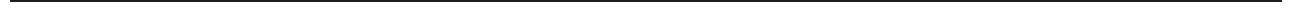
Fig. 3 FAPs drive spontaneous HO via endochondral ossi fi cation. a – c Spontaneous HO extended along the spine of a 22-week-old Acvr1 tnR206H/ + ; R26 NG/ + ; Tie2-Cre mouse. a µ CT detects calci fi ed heterotopic bone (bracket) but not the distal cartilaginous region of the lesion (asterisk). b Whole mount ABAR staining of the same mouse detects both lesional cartilage (blue; arrow) and bone (red; bracket). c Magni fi ed image of the boxed region in b . d – g Spontaneous HO (bracket) along the spine of a 6-week-old Acvr1 tnR206H/ + ; R26 NG/ + ;Pdgfr α -Cre mouse. The site of the most posterior chondrogenic area is shown at the asterisk in d and e . e ABAR staining shows the presence of two chondrogenic areas at the periphery of the predominantly boney lesion. f , g Higher magni fi cation images of areas denoted in e . Chondrogenic areas are shown at the arrow or bracket. h , i ABAR staining of the distal hindlimb of two 6-week-old Acvr1 tnR206H/ + ; R26 NG/ + ;Pdgfr α -Cre mice. Multiple chondrogenic areas (examples at arrows) are evident at the periphery of intramuscular boney lesions ( h ). In i , peripheral cartilage (arrow) is associated with HO of the Achilles tendon (arrowhead). B, heterotopic bone associated with the distal tibia/ fi bula. j – m Paraf fi n section of spontaneous HO from an adult Acvr1 tnR206H/ + ; R26 NG/ + ;Pdgfr α -Cre mouse stained by IHC for ACVR1 (brown) and counterstained with hematoxylin ( n = 7 mice). j Low magni fi cation image showing multiple areas of heterotopic cartilage and bone. Areas of mature (asterisk) and immature cartilage are evident. Staining for ACVR1 was most intense in immature cartilage, peripheral regions of mature cartilage, and in fi broproliferative and chondrogenic regions at the junction between HO and muscle (brackets). k – m Higher magni fi cation images of the labeled boxes in j . k ACVR1 expression was not detected in apparently mature heterotopic bone, characterized by abundant marrow elements. l Growth plate-like cartilaginous regions strongly stain for ACVR1 at the chondro-osseous junction (bracket). m Peripheral fi broproliferative and chondrogenic regions (asterisk) strongly expressed ACVR1. Scale bars = 500 µ m ( j ) and 100 µ m ( k – m